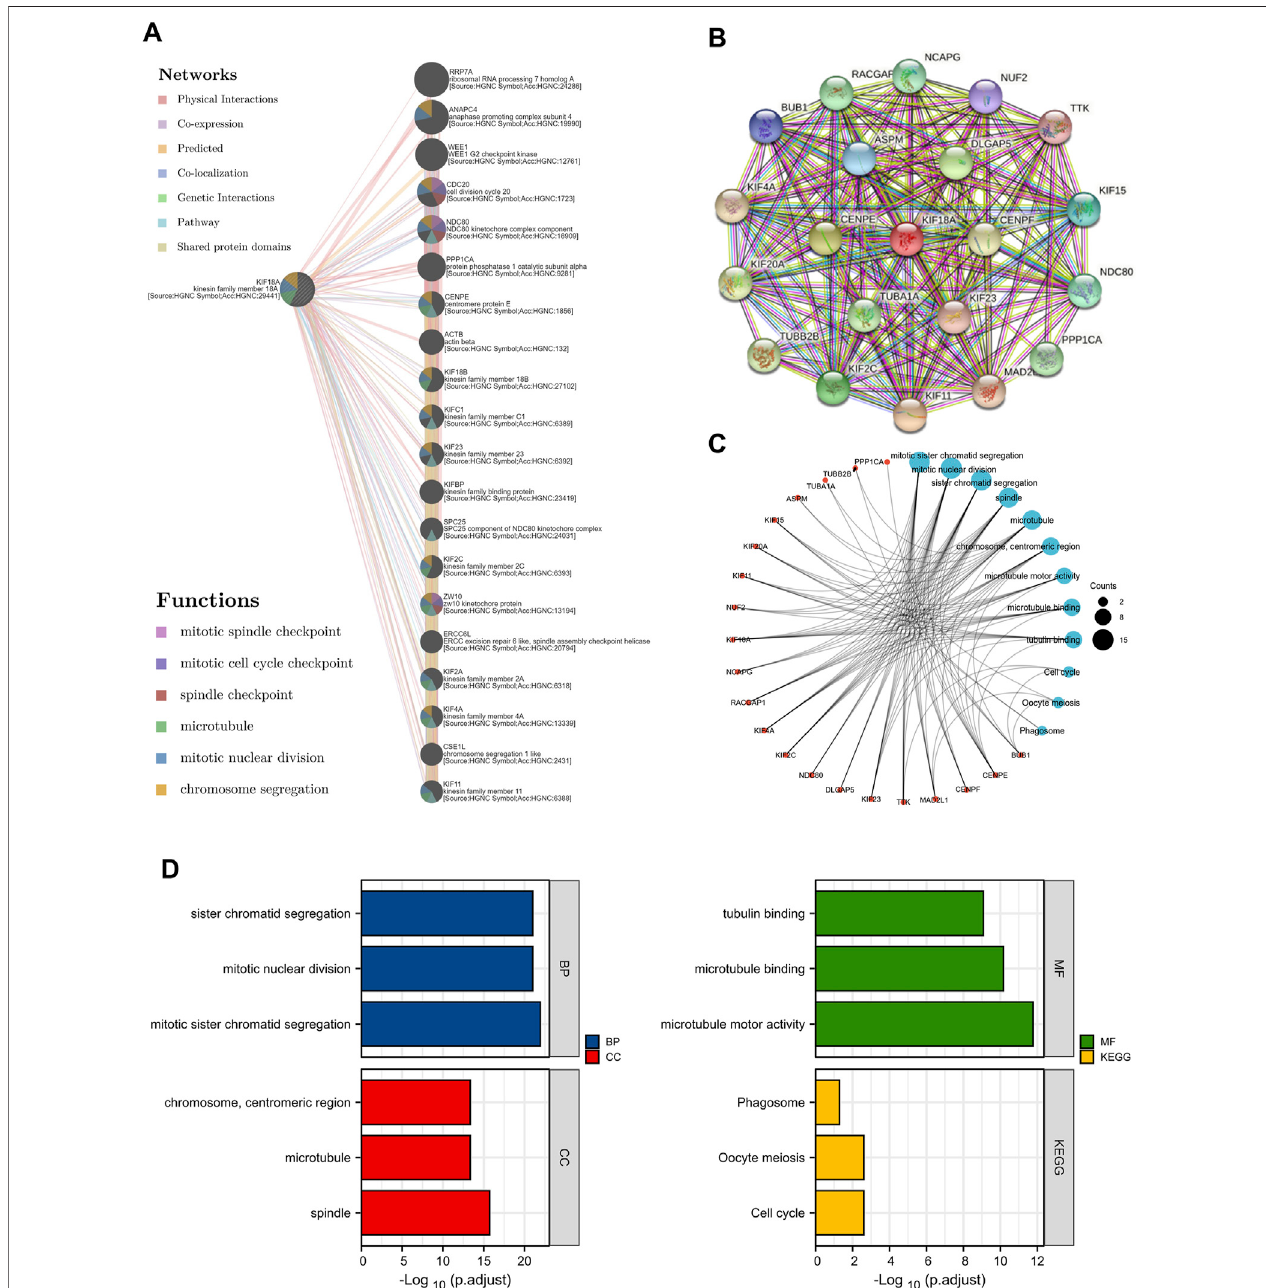
FIGURE 6 | Gene-gene interaction network, PPI network and enrichment analysis related to binding proteins of KIF18A. (A) KIF18A associated gene-gene interaction network. (B) KIF18A-related PPI network. (C) Enrichment analysis network of KIF18A-related molecules. (D) GO and KEGG analysis.